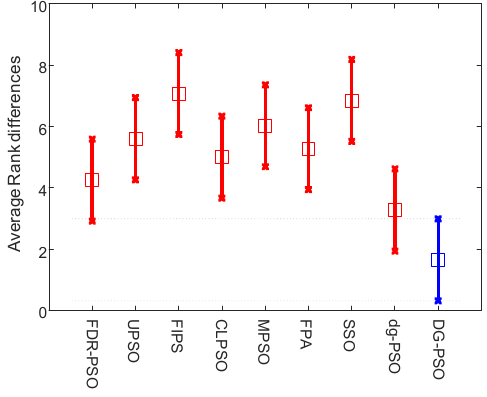
Figure 3. Friedman test of 50D problems. Table 5. Numerical rankings of the Friedman test.